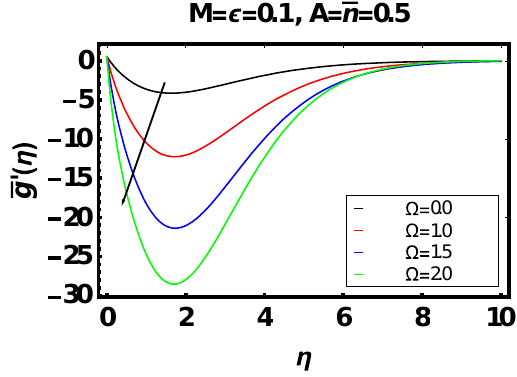
Figure 3. Velocity along 𝑥̅ -direction for variant Ω.